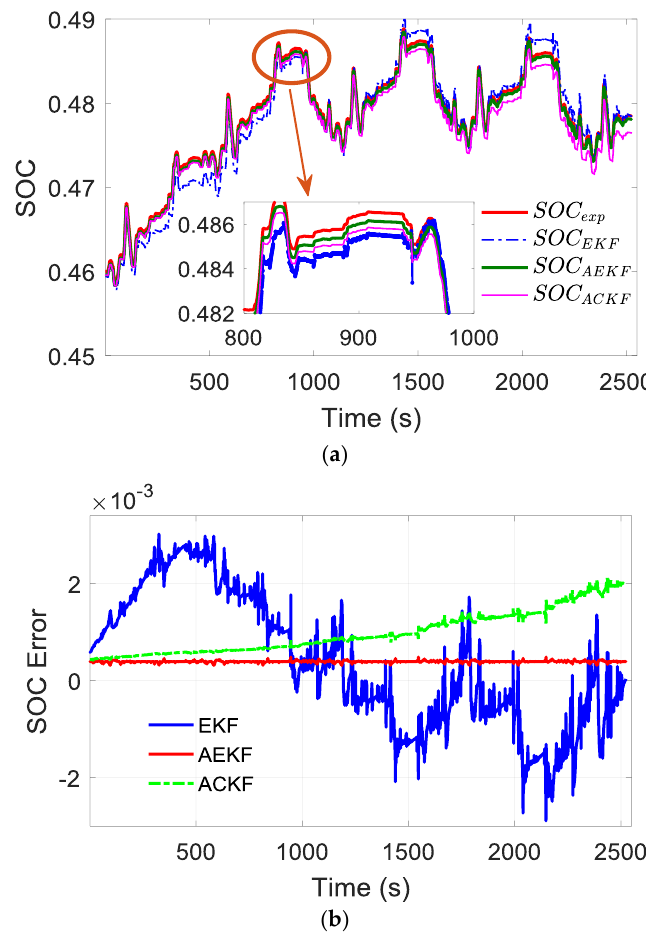
Figure 11. Validation results for SOC estimation under US06 condition at 30 °C: ( a ) SOC estimation profiles with different methods; and ( b ) SOC errors.